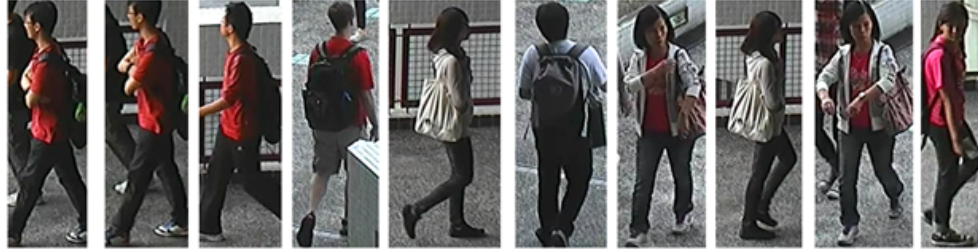
Figure 6. Search results for a human-generated query of a person wearing a red shirt, black pants, and black shoes in the CUHK03 dataset.